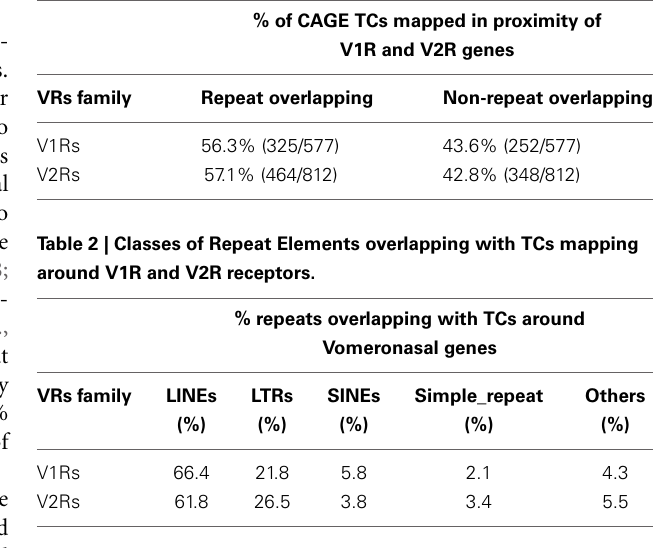
Table 1 | Percentage of repeat and non-repeat overlapping TCs